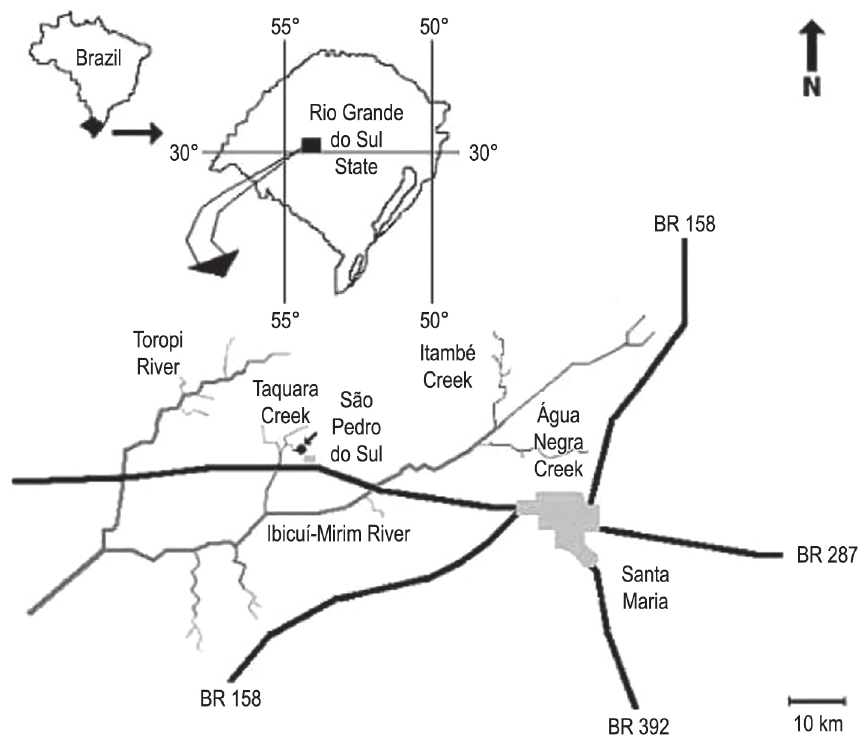
Figure 1. Schematic representation of the location of the Passo Taquara stream in the central region of the Rio Grande do Sul state,